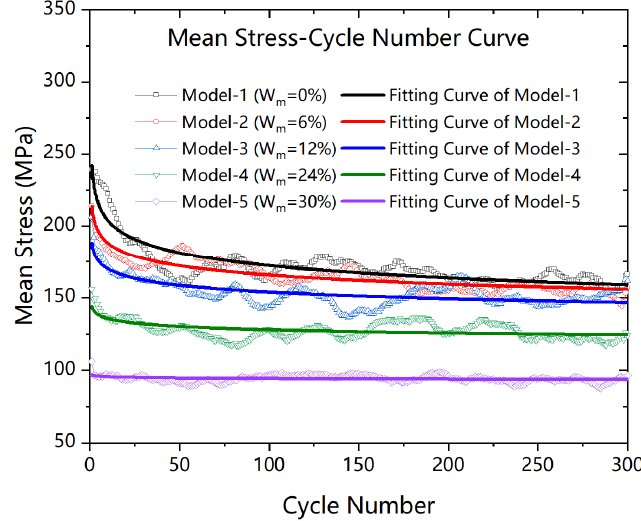
Figure 6. Comparison of mean stress-cycle number curves at different humidity.